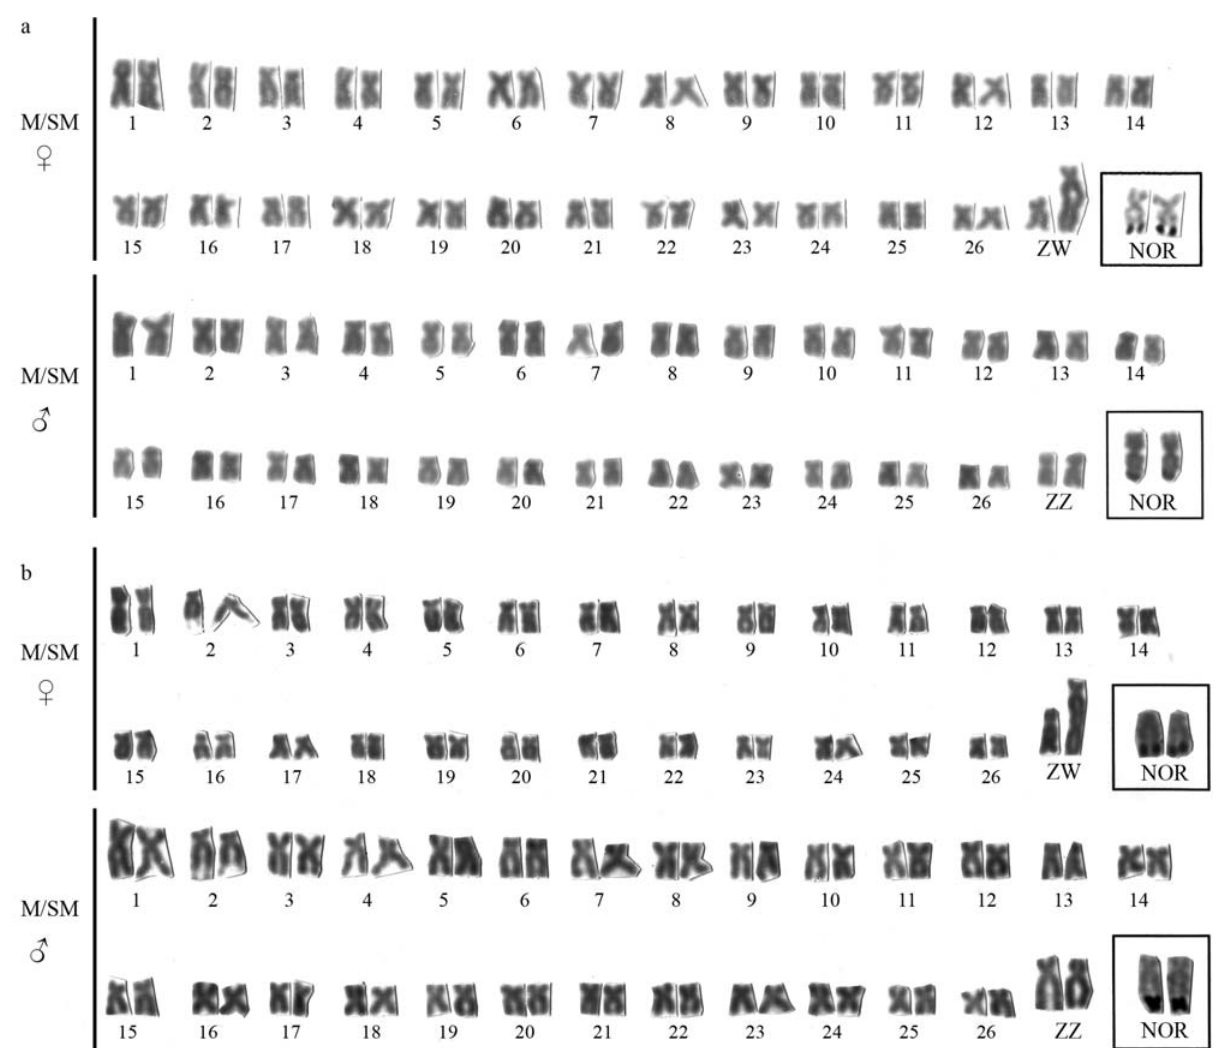
Figure 1 - Giemsa-stained karyotype (female and male) of Leporinus macrocephalus (Piauçu) (a) and Leporinus elongatus (Piapara) (b). Inbox, the NOR-bearing chromosome pair